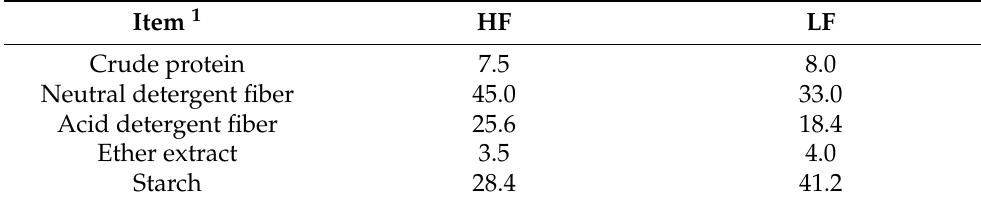
Table 1. Chemical composition of two substrates (%,